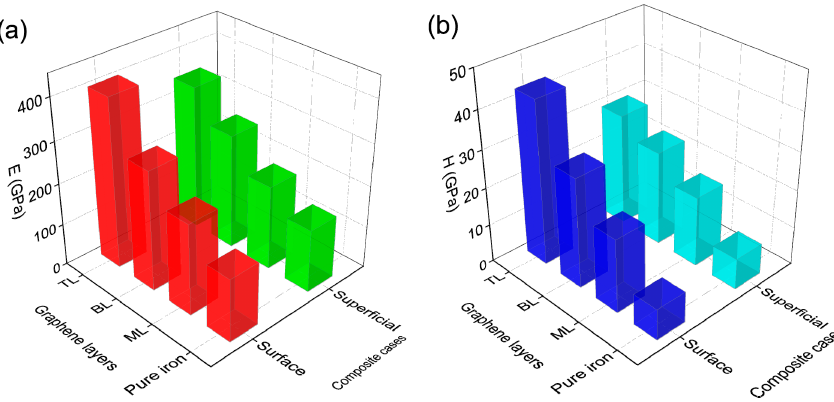
Figure 3. ( a ) Elastic modulus of composite cases (pure iron, ML, BL, TL); ( b ) hardness of composite cases.